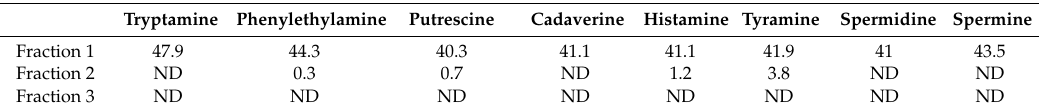
Table 5. Degradation percentages (%) of the eight biogenic amines in the three fractions by Sephadex separation incubation with 50 mg / L of the eight biogenic amines at pH 4.0, 33 ◦ C for 2